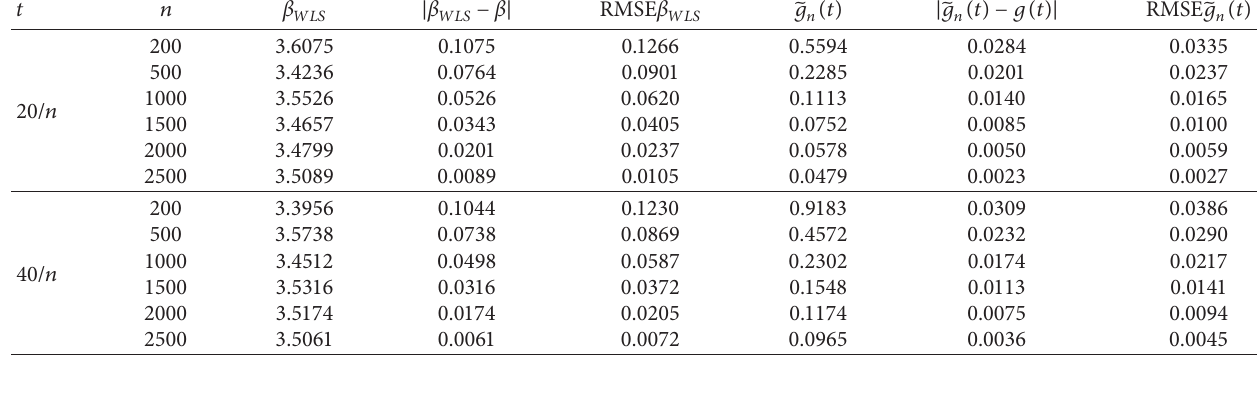
􏽥 g ( t ) with β � 3 . 5 and g ( t ) � sin ( 2 π t ) . n WLS and